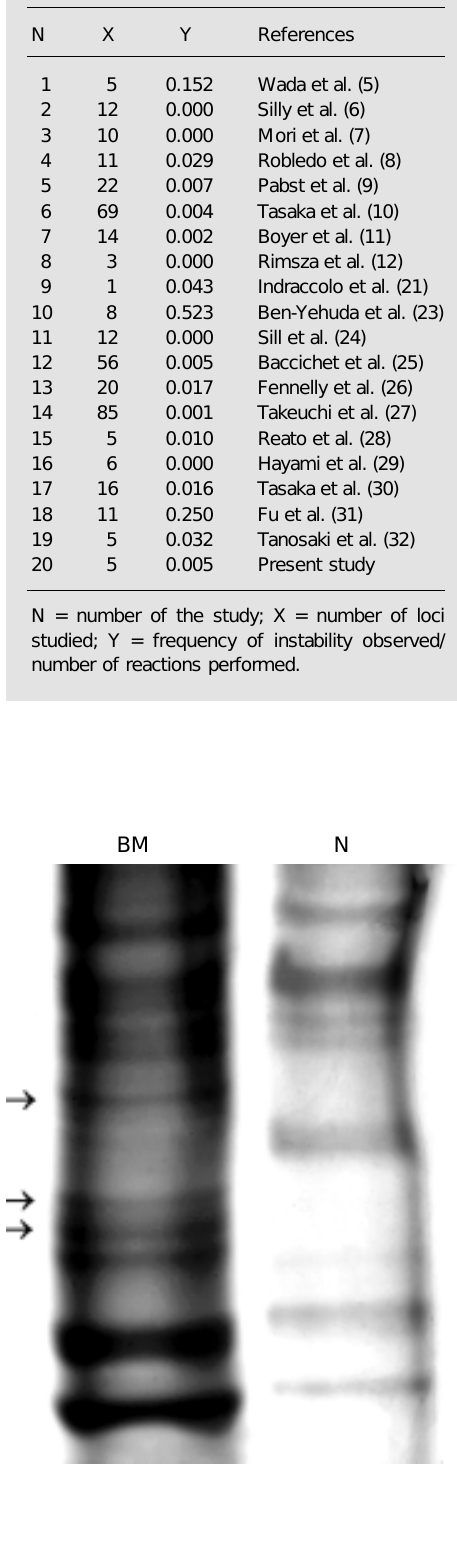
Table 3. Frequencies of microsatellite instability observed in 20 different studies.